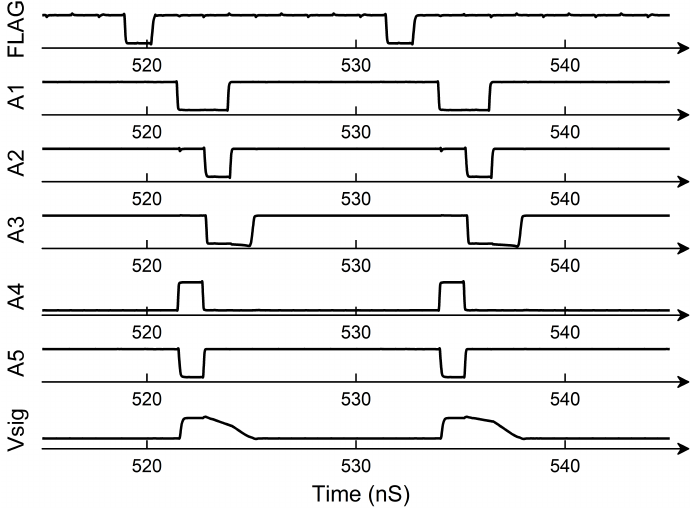
Figure 8. Simulation results of the signals in